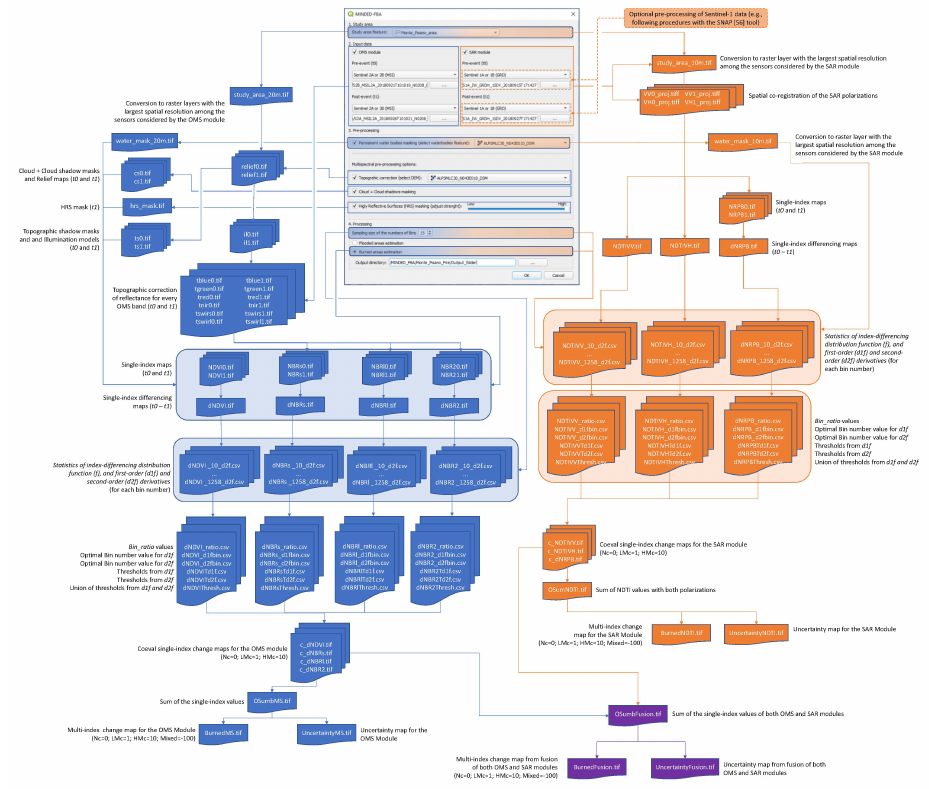
Figure A1. Workflow of the MINDED-FBA procedures and outputs. Blue and orange describe procedures and outputs related to the OMS and SAR modules respectively; violet describes data fusion procedures and